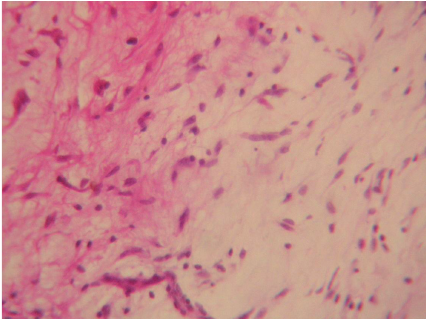
Figure 8: Histopathological examination showing spindle-shaped fibroblasts in loose myxoid